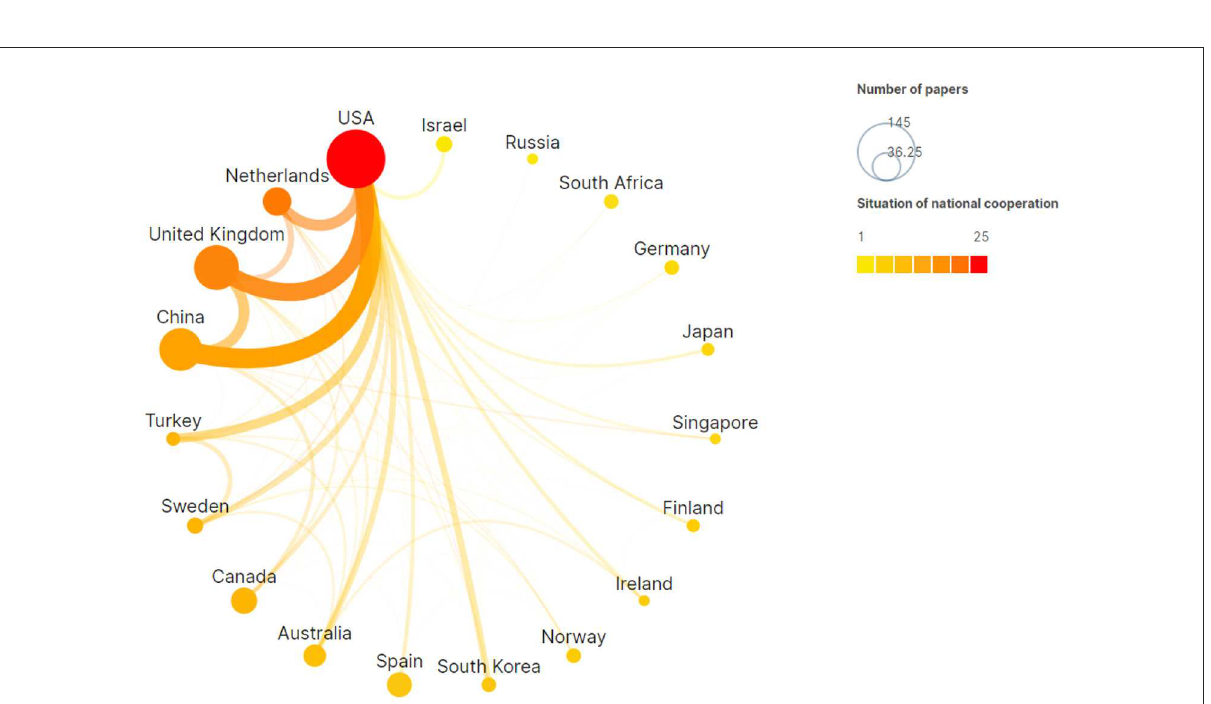
FIGURE2 Chord graph of inter-country number of papers and